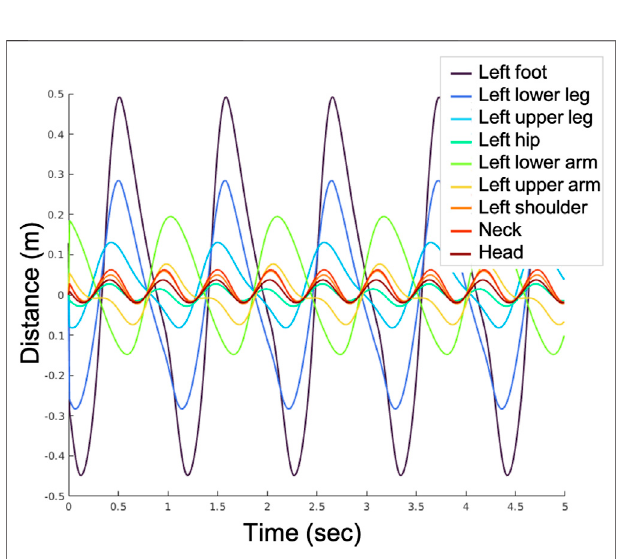
FIGURE 5 | Limbs ’ displacement during